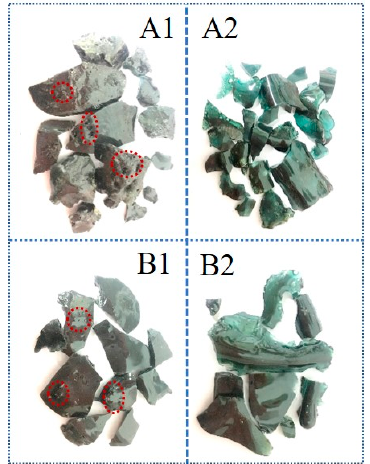
Figure 7. Appearance and morphology of the tundish covering fluxes before and after plasma heating: A1, A group: before heating; A2, A group: after heating; B1, B group: before heating; B2, B group: after heating.